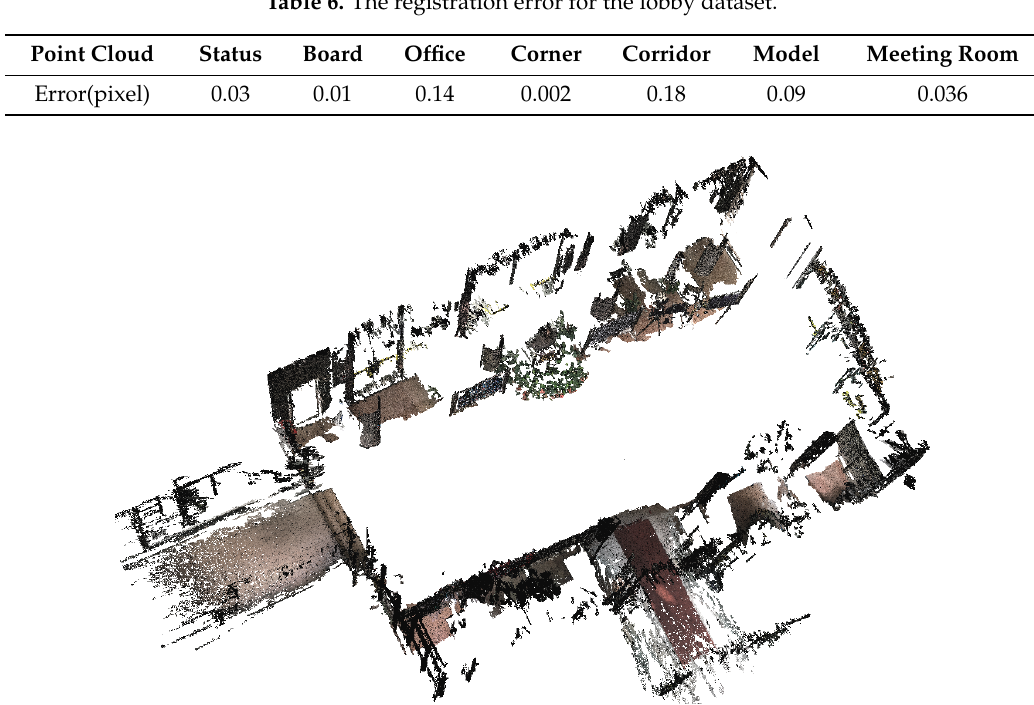
Table 6. The registration error for the lobby dataset.